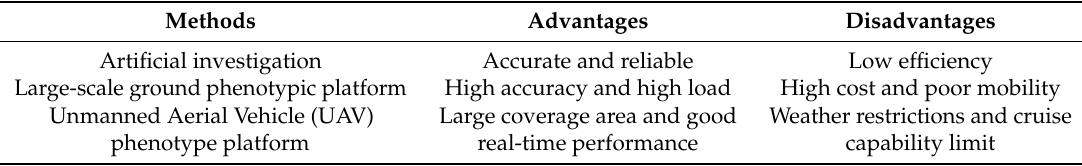
Table 1. Advantages and disadvantages of current methods to obtain crop phenotype.